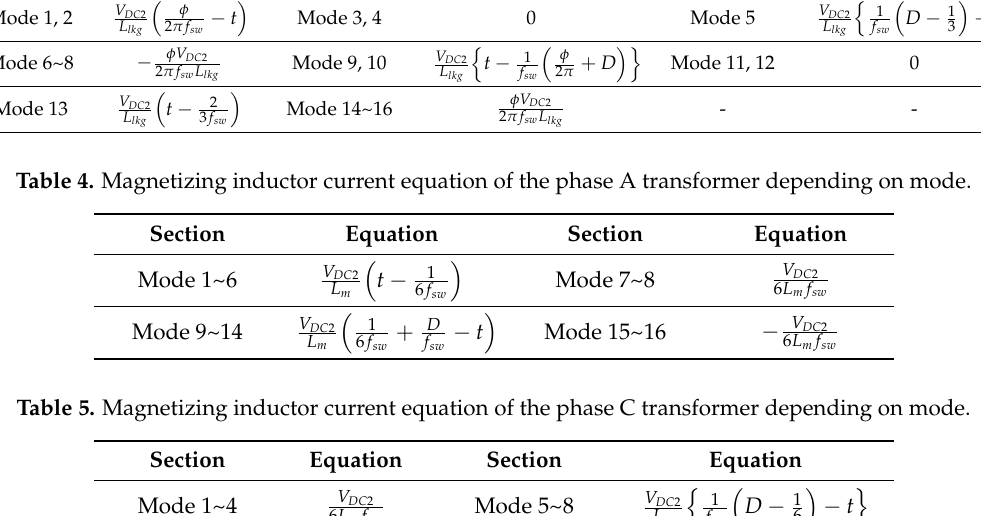
Table 3. Current equation of the secondary side phase C transformer depending on mode. Section